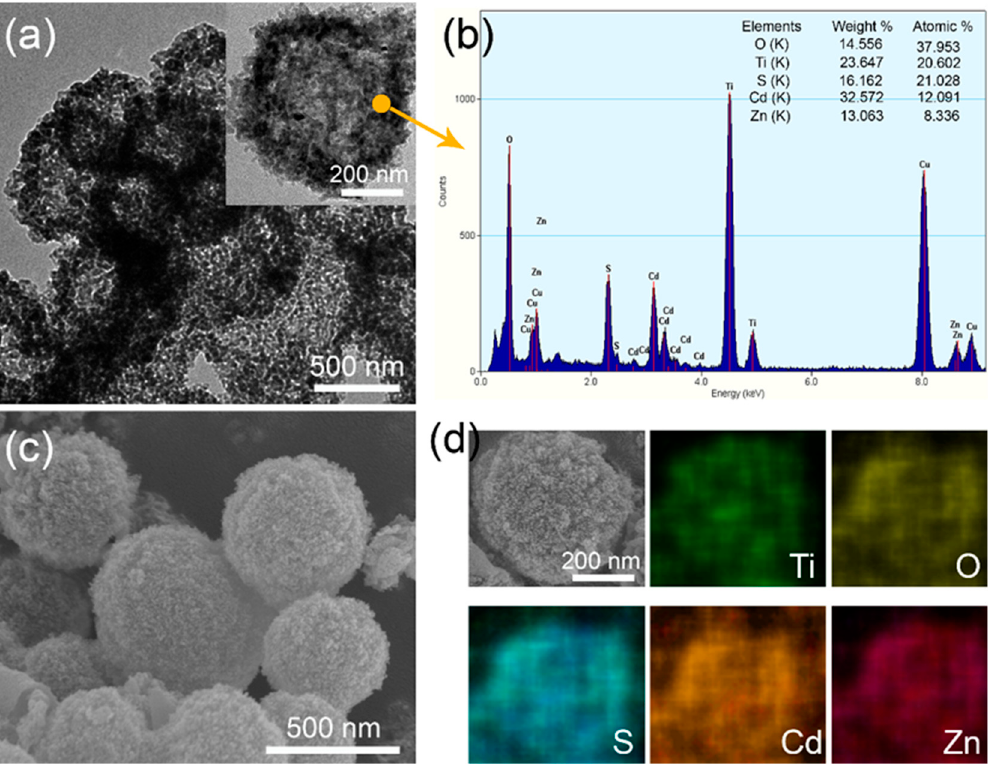
Figure 4. ( a ) TEM of ZnS / CdS@TiO 2 HMS, the inset is magnified TEM of single ZnS / CdS@TiO 2 HMS; ( b ) EDS of ZnS / CdS@TiO 2 HMS from the selected spot; ( c ) SEM of ZnS / CdS@TiO 2 HMS; ( d ) surface SEM elemental mapping of ZnS / CdS@TiO 2 HMS. Table 1. Size effect of TiO 2 HMS on photovoltaic performance of ZnS/CdS QDSSC. Size (nm)